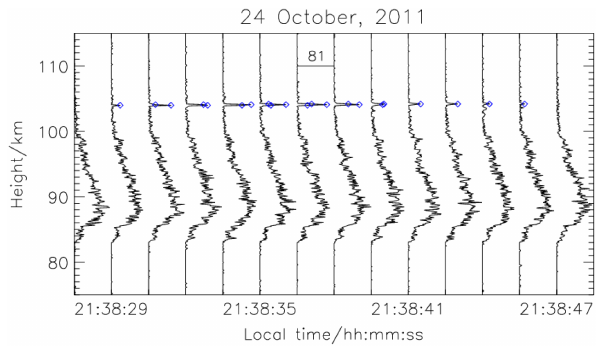
Figure 10. Evolution of a typical meteor trail observed on the top side of the Na layer, which occurred on 24 October 2011.